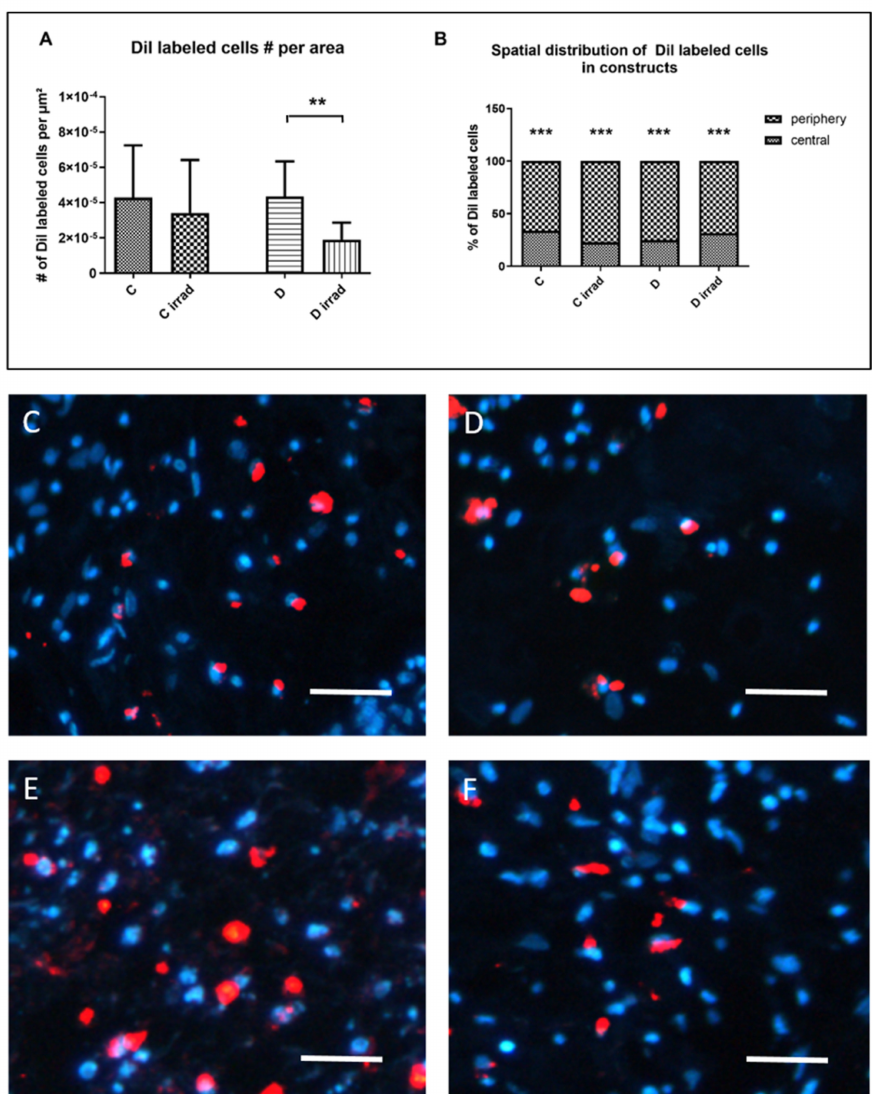
Figure 9. Survival of implanted, DiI labeled osteogenic MSCs in constructs, 12 weeks (group C/C irrad) and 10 days (D/D irrad) after CSFD surgery. ( A ) A significantly lower cell survival was noted in irradiated femora 10 days after CSFD, compared to unirradiated controls (** p ≤ 0.01). After 12 weeks, the difference was not significant. ( B ) In all groups, a significantly higher number of cells survived in the periphery compared to the center of constructs (*** p ≤ 0.001). However, the spatial distribution did not differ between different groups. Values are given as mean ± SD. ( C – F ): Representative images of DiI positive cells (red) and DAPI staining (blue) (( C ): group C; ( D ): group C irrad, ( E ): group D; ( F ): group D irrad) (Total magnification × 100, Scale bar 50 µ